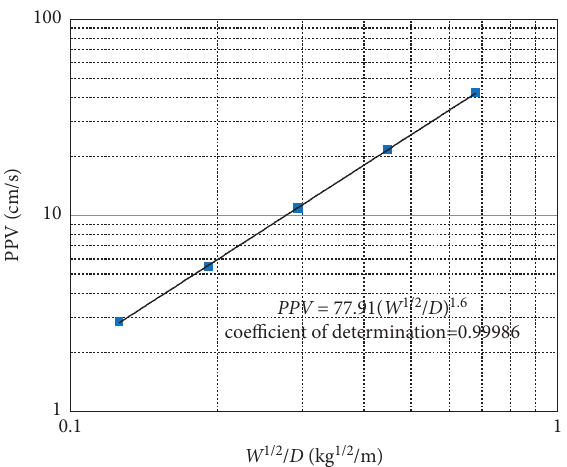
Figure 5: Vibration attenuation law of single-hole